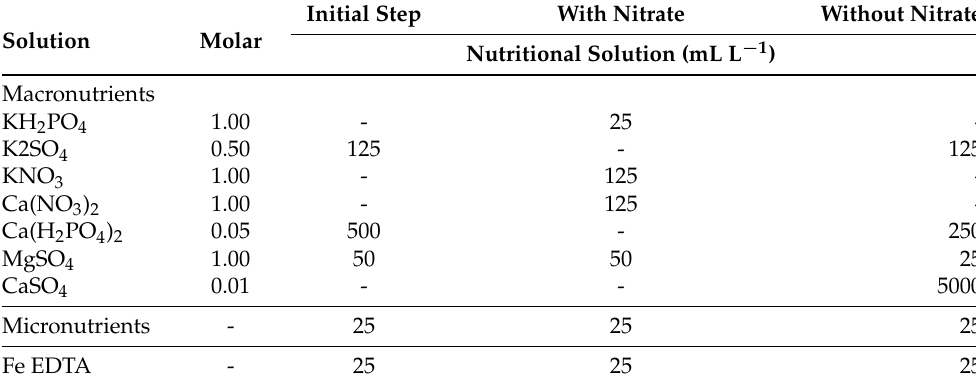
Table 1. Composition of Hoagland and Arnon (1950) nutrient solution in the initial stage and with and without nitrate for cultivation of Glycine max L. in symbiosis or not with Bradyrhizobium japonicum . Initial Step With